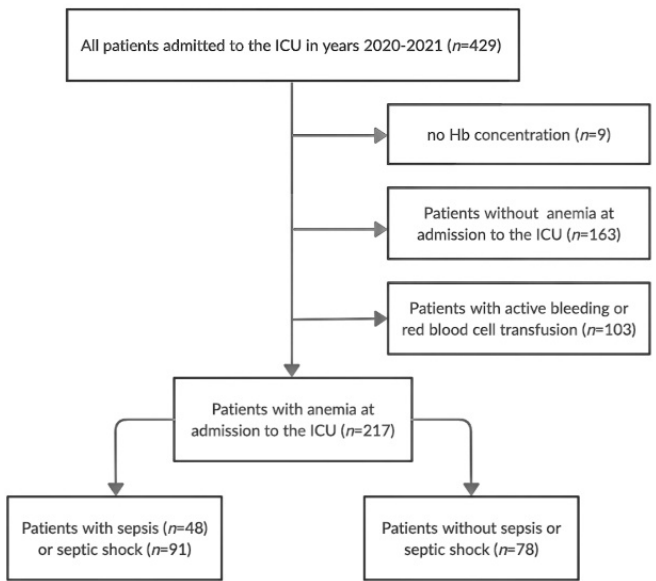
Figure 1. The study flow chart. Hb—hemoglobin, ICU—intensive care unit. Demographic, clinical, and laboratory data were retrieved from the electronic